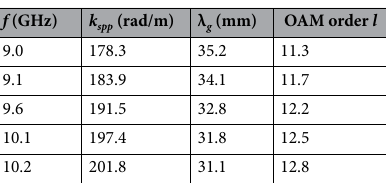
Table 1. Theoretical parameter values of OAM mode at different frequencies.